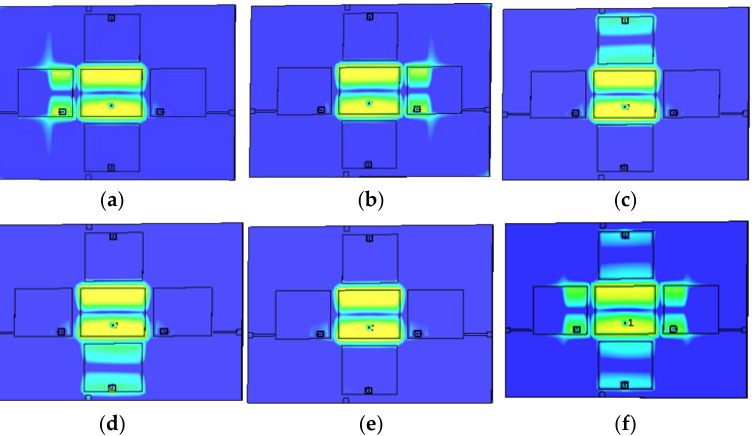
Figure 7. Simulated surface current distribution at 2.5 GHz: ( a ) left ; ( b ) right ; ( c ) top ; ( d ) bottom ; ( e ) all OFF ; and ( f ) all ON. ( e ) all OFF; and ( f ) all ON.